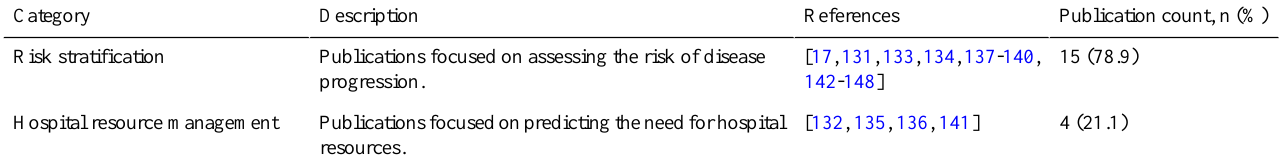
Table 4. Disease Progression publications subclassified into 2 categories: (1) risk stratification and (2) hospital resource